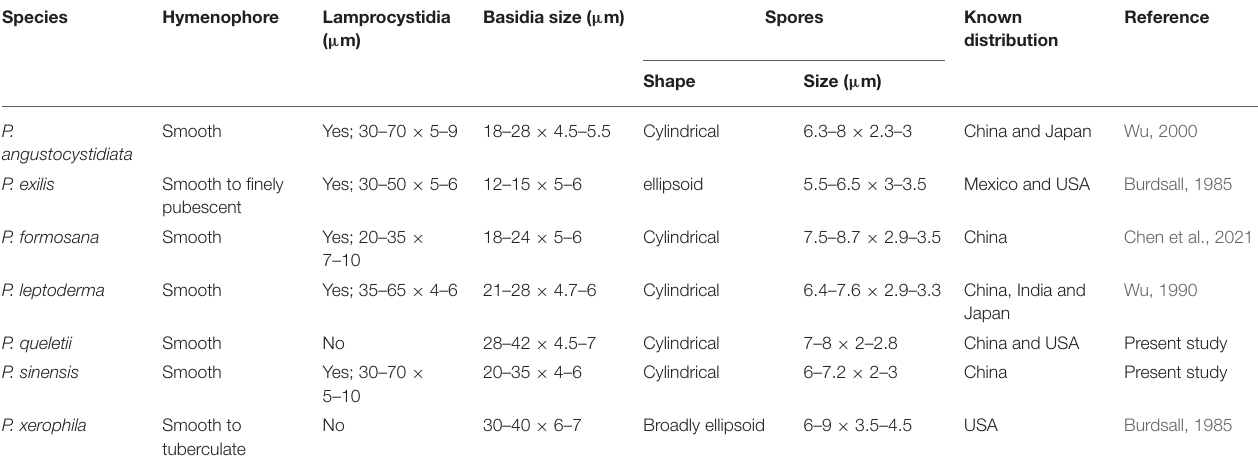
TABLE 3 | Diagnostic characters for species of Phanerochaetella .